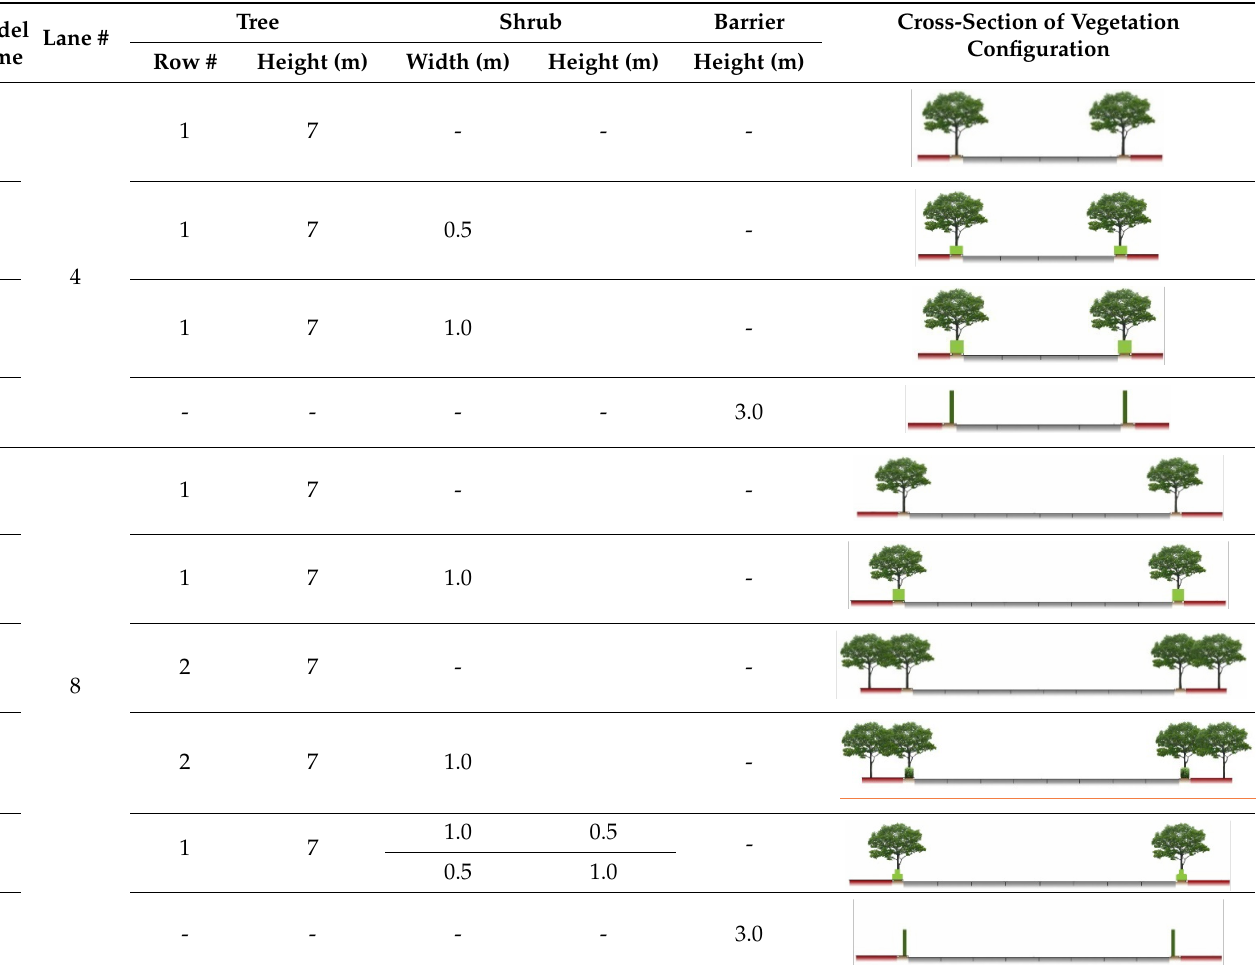
Table 1. Modeled vegetation configurations categorized by roadway width.